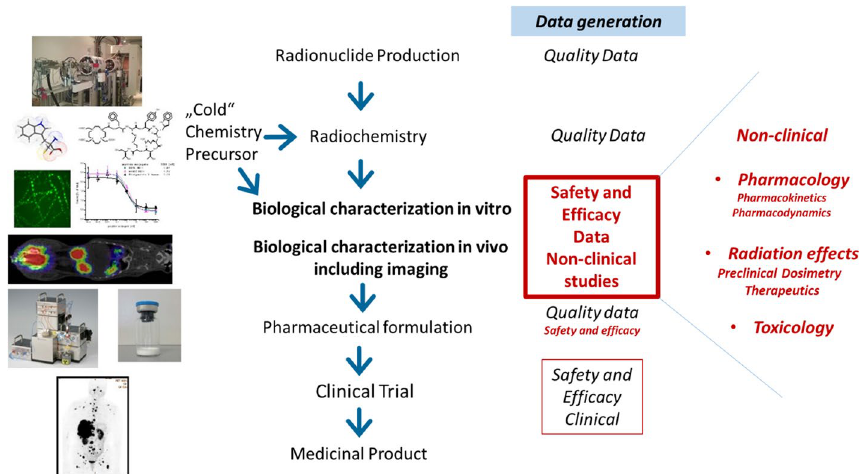
Fig. 1 Clinical translation of radiopharmaceuticals: the development of a radiopharmaceutical